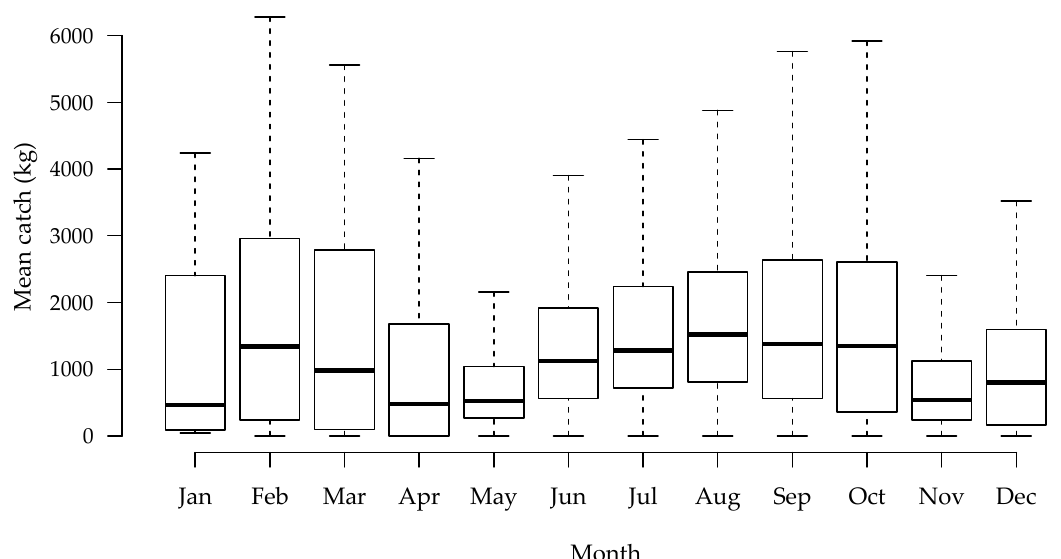
Figure 1. Mean monthly catch of skipjack from coastal gillnet fleet based in the Ocean Fishing Port (OFP) of Cilacap, Central Java during 2010–2017 (the bars represent standard error).